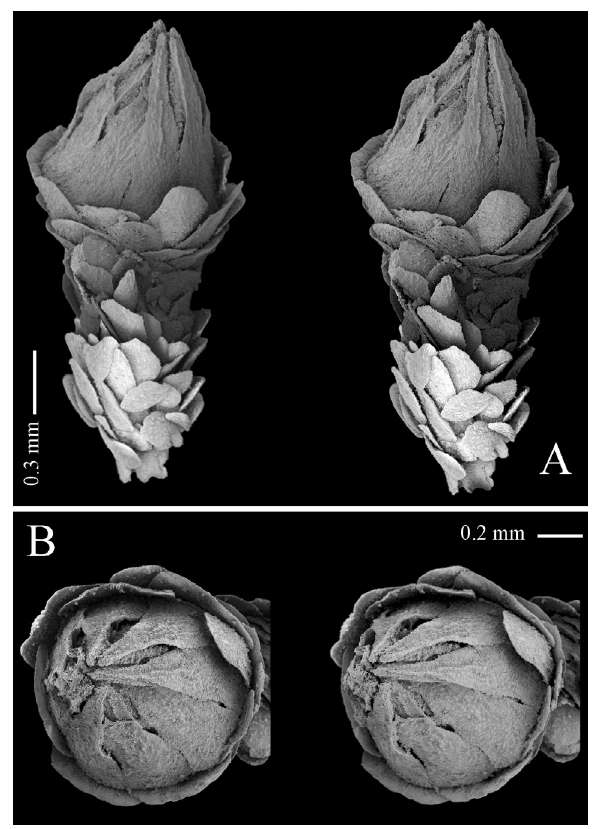
Fig . 21. – Plumarella ( Faxiella) abietina (Studer, 1894) n. comb., holotype (MCZ 4802): A, polyp on adaxial view, stereo pair; B, polyp on oral view, stereo pair. [Photo: Stephen D. Cairns, NMNH,